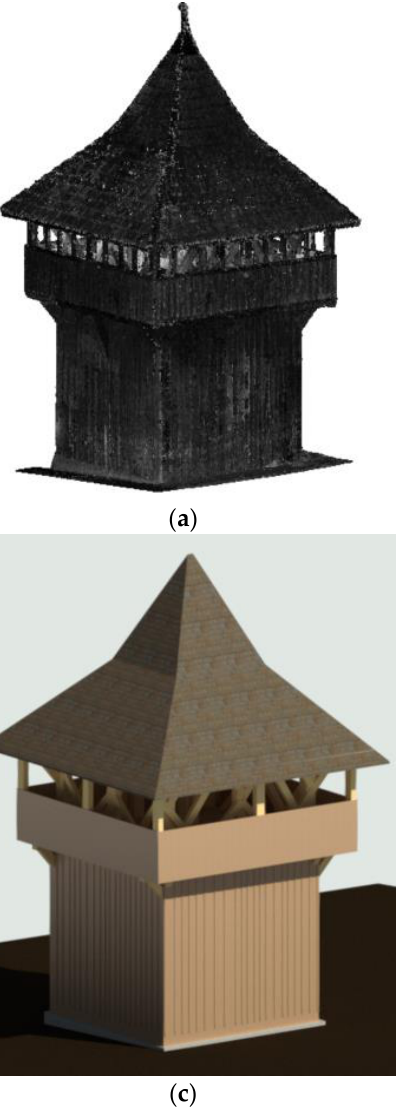
Figure 10. Work results for the belfry: ( a ) comprehensive point cloud with TLS-UAV integration; ( b ) generated model based on a point cloud; ( c ) visualization of the HBIM model; ( d ) visualization of the cross-section (interior) of the building.